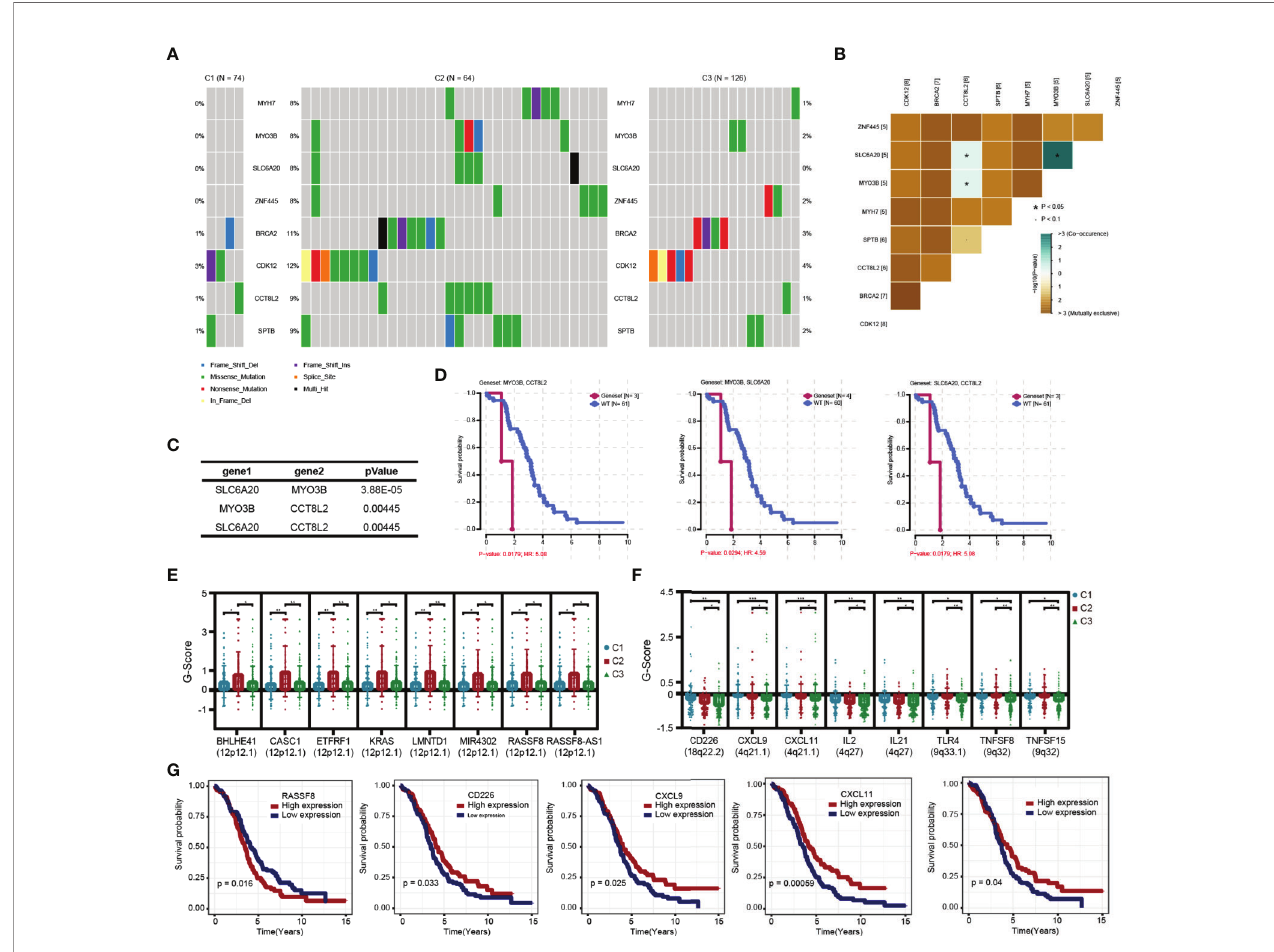
FIGURE 10 | Genomic variation analysis of immune subtypes. (A) Differential high frequency mutation genes in C2 subtypes. (B) Correlation heatmap of co-mutated genes in C2 subtype. (C) Correlation of co-mutated genes in C2 subtypes. (D) Survival and prognosis of patients with co-mutated genes. (E) Signi fi cantly increased copy number genes in C2 subtype. (F) Signi fi cantly decreased copy number genes in C3 subtype. (G) Survival curve of differential copy number genes associated with